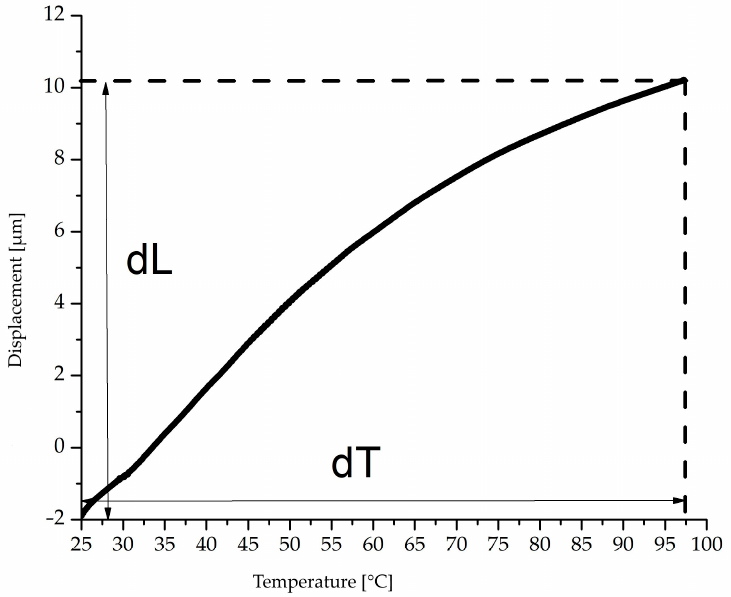
Figure 2. Displacement and temperature course of DMA measurements with constant load at 10N.